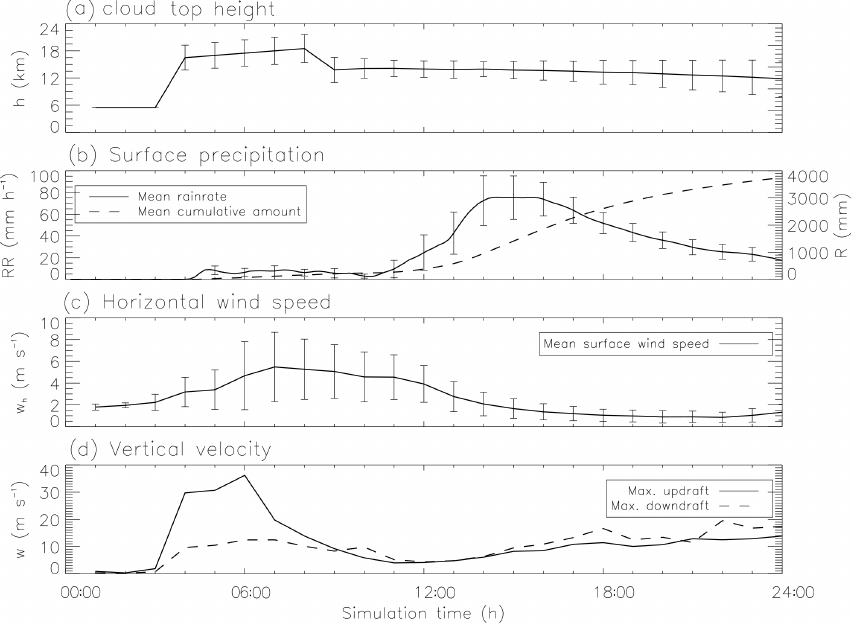
Figure 2. Temporal evolution of (a) the mean cloud top height, (b) the mean accumulated rain and rain rate at the surface, (c) the mean surface horizontal wind speed, and (d) the maximum of the updraughts and downdraughts. The averages are obtained over the entire grid points of the domain and given with ± 1 standard deviation. The initial time of the simulation is 09:00UTC on 24 May